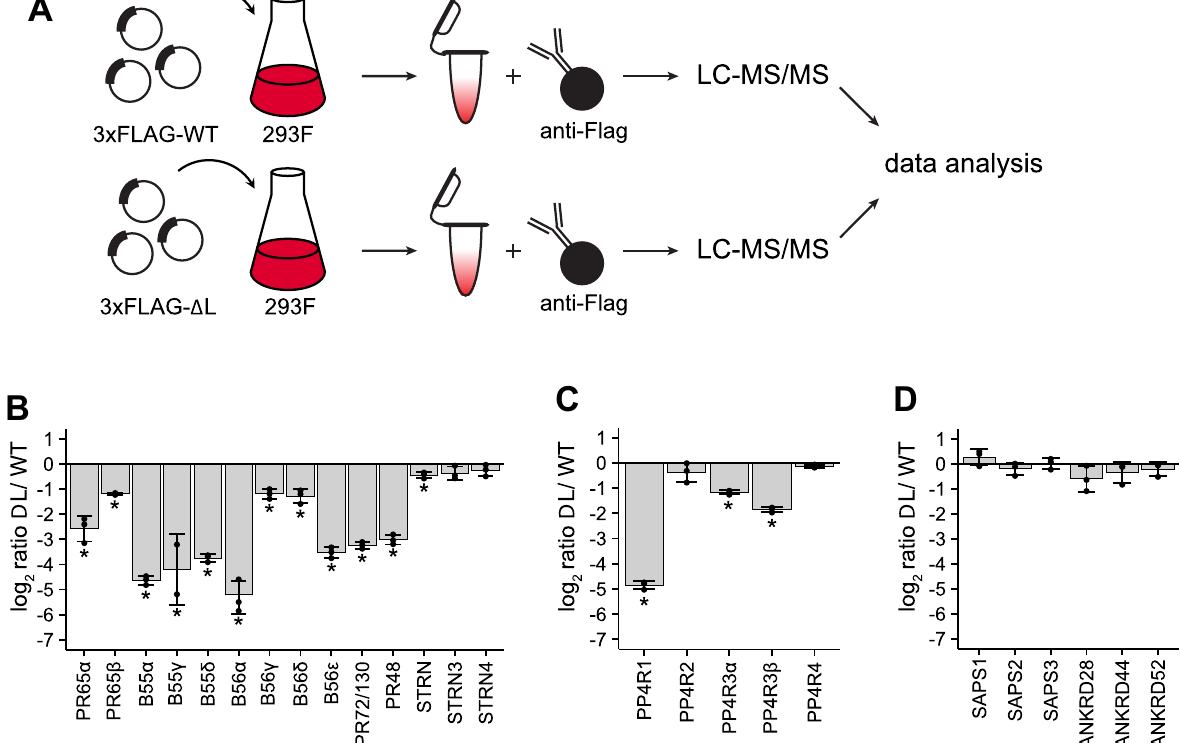
Figure 2. The Effects of deleting the C-terminal leucine on holoenzyme subunit composition of PP2A, PP4, and PP6. ( A ) Workflow for Flag affinity-purification mass spectrometry. Flag IPs were performed for PP2Acβ ( B ), PP4c ( C ), and PP6c ( D ) using either the wild-type or ΔL mutant and analyzed, and the log 2 -ratios are plotted. Individual ratios are represented. Error bars represent the standard deviation of three replicates. * p <